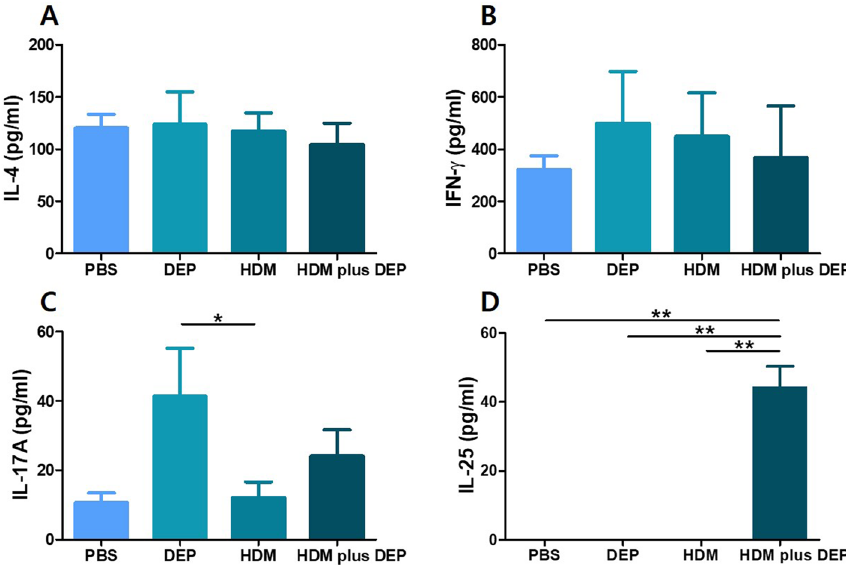
Figure 6. Measurement of cytokines in the spleen cell culture by ELISA. Concentration of ( A ) IL-4, ( B ) IFN- γ, ( C ) IL-17A, and ( D ) IL-25 in spleen cell culture of each group detected by ELISA. IL-25 was significantly increased in mice co-exposed to HDM and DEP. Data are expressed as mean ± standard error mean. * p < 0.05, ** p <